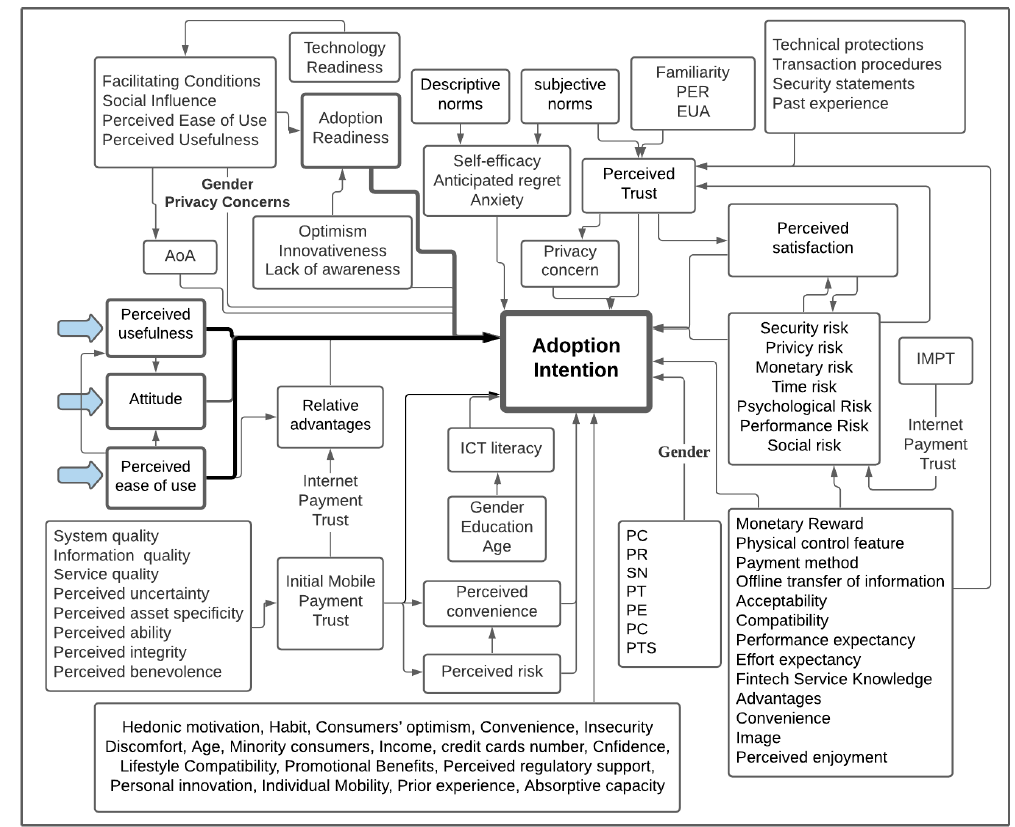
Figure 4. The behavioural intention model of electronic payment. PER: Perceived Environmental Risk, EUA: Espoused Uncertainty Avoidance, PC: Perceived cost, PR: Perceived risk, SN, Subjective norms, PT: Perceived trust, PE: Perceived Enjoyment, PC: perceived convenience, PTS: Perceived transaction speed, AoA: Attractiveness of Alternatives, IMPT: Initial Mobile Payment Trust, ICT: Information and communications technology.